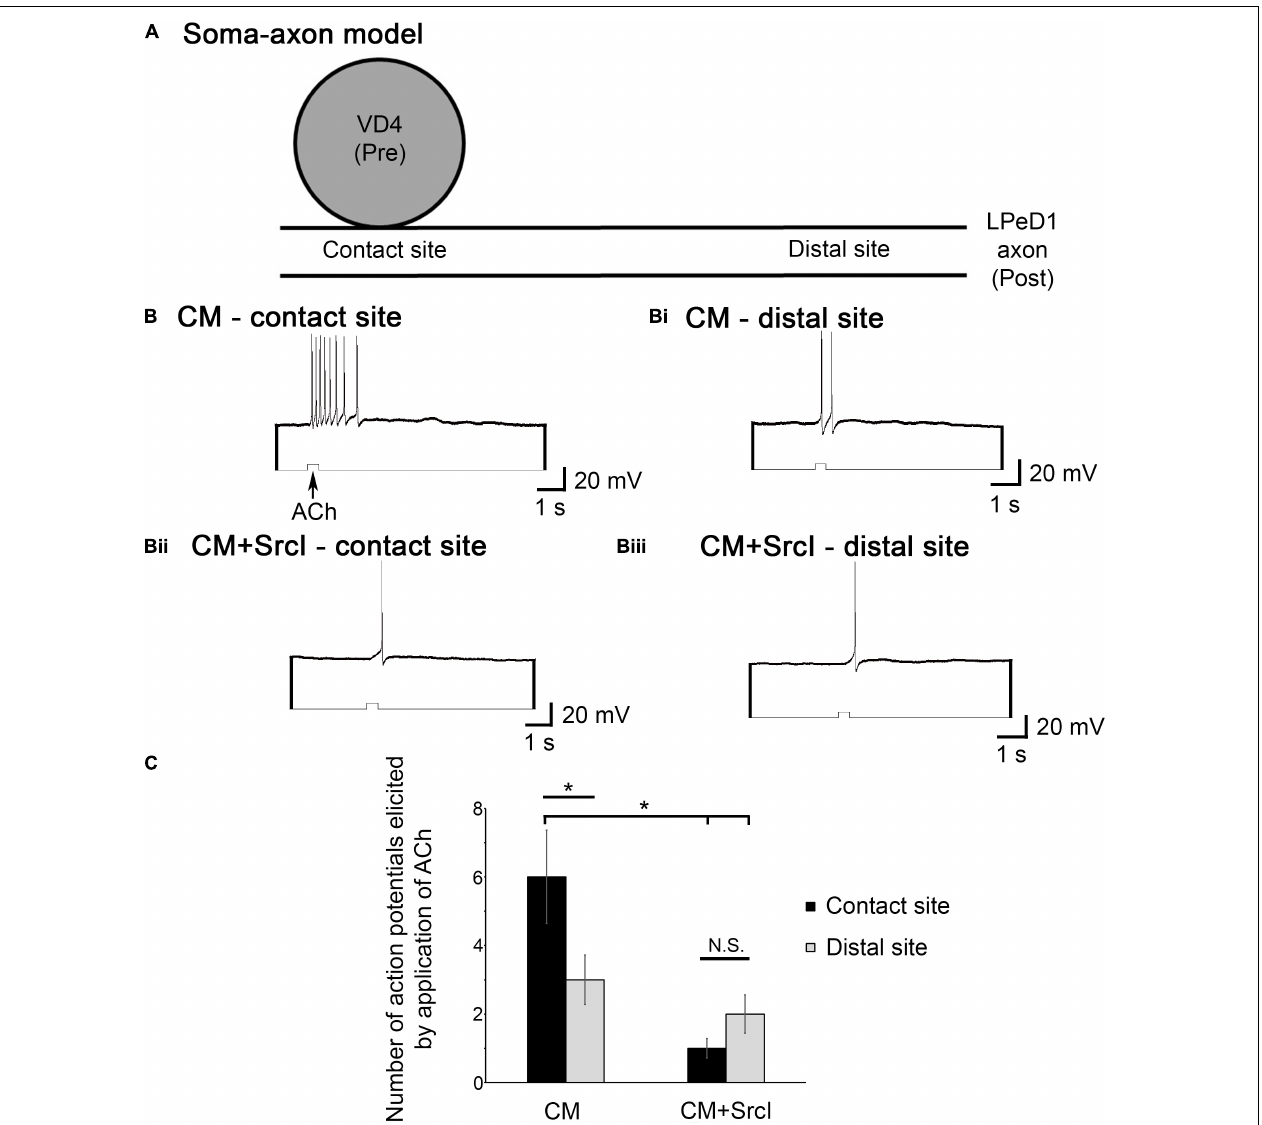
FIGURE 7 | Src family kinases (SFKs) are required for the functional, postsynaptic clustering of nicotinic acetylcholine receptors (nAChRs) at the synaptic contact site. (A) Diagrammatic representation of the soma–axon preparation, outlining synaptic contact sites versus extrasynaptic (distal) sites of acetylcholine (ACh) application. (B–Biii) Individual visceral dorsal 4 (VD4) somata and left pedal dorsal 1 (LPeD1) axons (somata removed) were paired overnight in ganglion-conditioned media (CM) or CM + SrcI (5 µ M). The next day, after confirming that synapses had formed, the LPeD1 axon was impaled with a sharp intracellular electrode and held at –100 mV for consistency. ACh was pressure-applied at both contact (B , Bii) and distal sites ( Bi , Biii ; distal), to compare the response of LPeD1 to ACh according to the number of action potentials elicited by the puff of ACh. (C) Summary of the number of action potentials elicited by puffs of ACh at contact versus distal sites. The number of action potentials elicited by puffs of ACh at the contact site was higher on average in CM ( n = 13) than those elicited at the distal sites. For soma–axon pairs cultured in the presence of SrcI ( n = 10), there was no differences in the number of action potentials induced by a puff of ACh at contact or distal sites (N.S., not significant). Significantly more action potentials were induced at the synaptic contact site in CM versus CM + SrcI. Significance values were determined using a mixed model ANOVA ( p < 0.05). Error bars represent